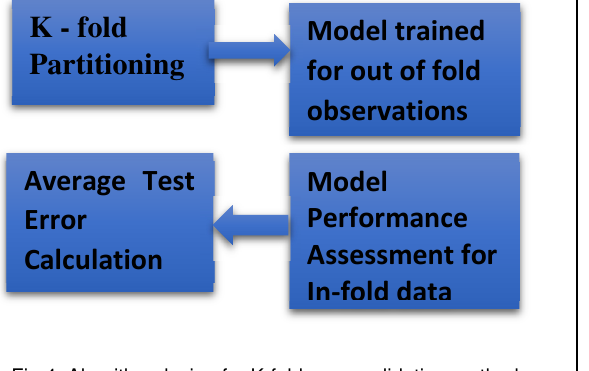
Fig.4: Algorithm design for K-fold cross validation